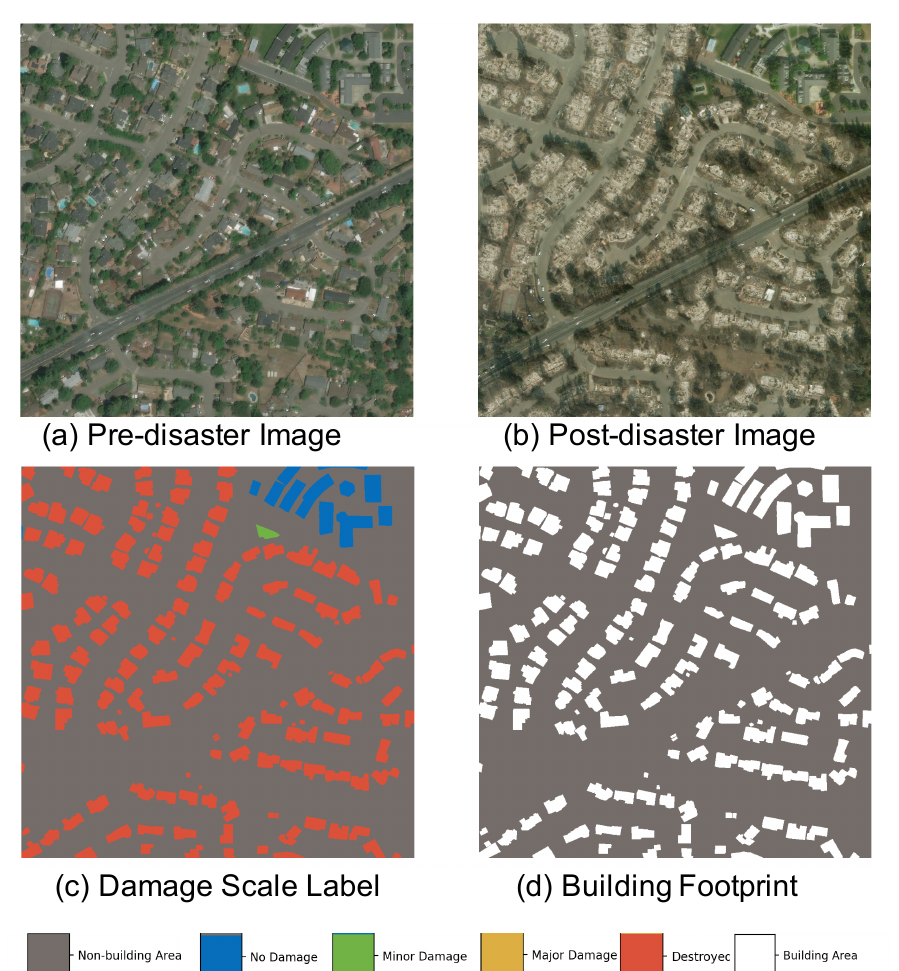
Figure 2. Example of xBD dataset. From left to right: ( a ) Pre-Disaster Image, ( b ) Post-Disaster Image, ( c ) Damage Scale Label, ( d ) Building